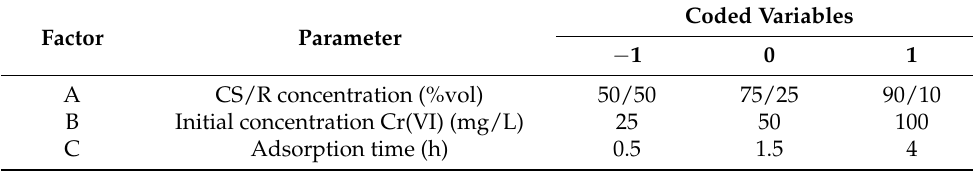
Table 1. Independent variables and their